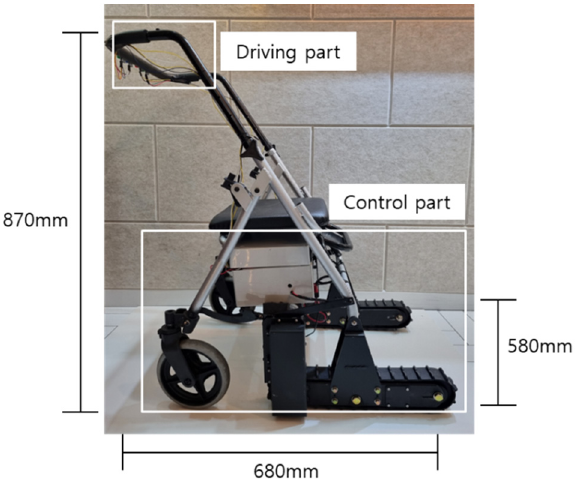
Figure 1. Caterpillar-type walker.